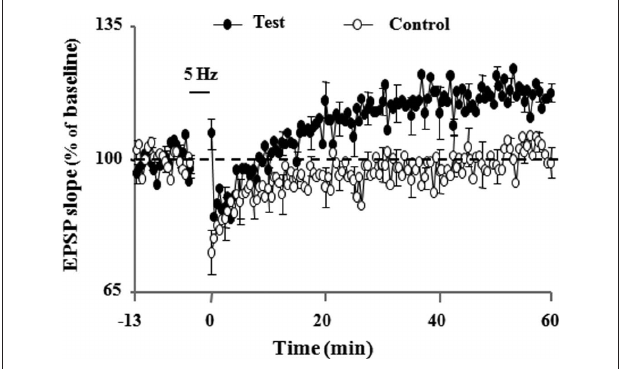
Figure 3 | Pharmacological inhibition of intracellular Ca 2 + stores by cyclopiazonic acid (CPA; 3 μM) led to LTP induction by a low-frequency (5 Hz, 900 pulses) stimulation protocol. Illustrations of the time course of mean percentage change in the synaptic responses during 10 min before and 60 min after delivery of 5 Hz stimulation (5 Hz/3 min, solid horizontal line) to the control and test path. LTP is observed only in test path (adapted from Kumar and